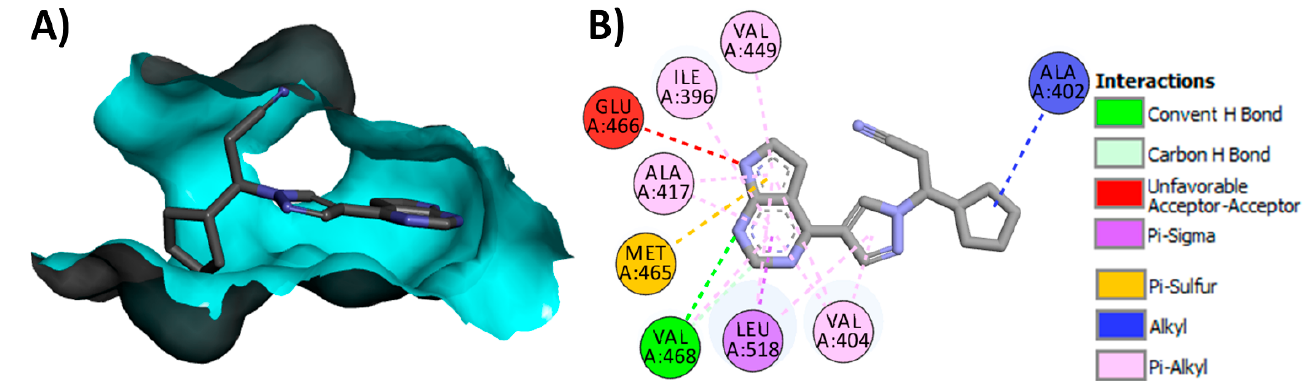
Figure 56. Binding modes of ruxolitinib (shown as sticks) into the DCLK1 kinase domain (pdb: 7F3G): ( A ) 3D binding mode, receptor shown as a hydrogen bond surface; ( B ) 2D binding mode showing different types of interactions with DCLK1 kinase domain; hydrogen atoms were omitted for clarity; this figure was generated using Discovery Studio Visualizer (V16.1.0.15350).